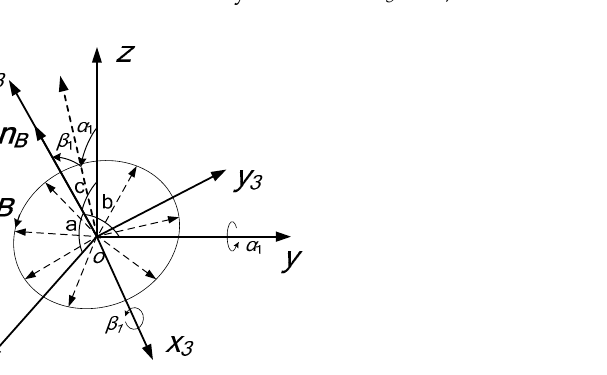
Figure 4. The URMF coordinate system ox 3 y 3 z 3 .